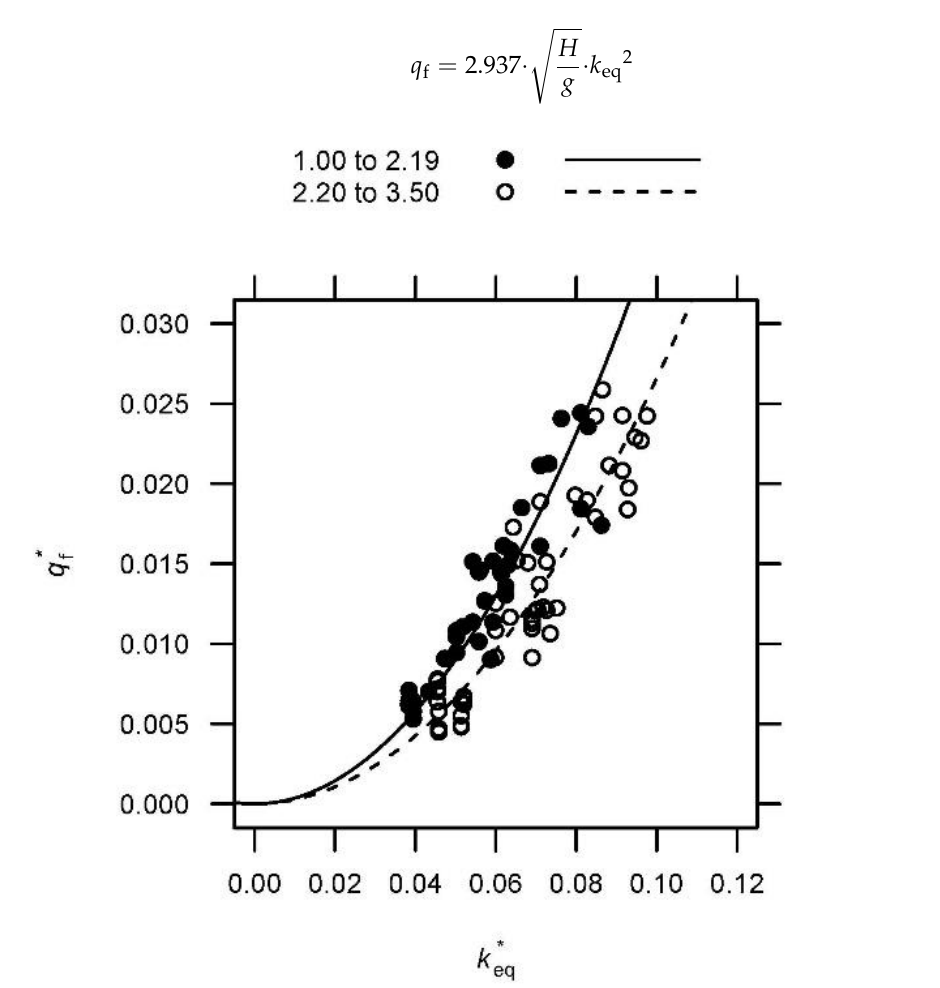
Figure 19. Regression models proposed to estimate the failure discharge ( q f ) for dams with steep slopes ( Z dss < 2.2) and gentle slopes ( Z dss > 2.2 )